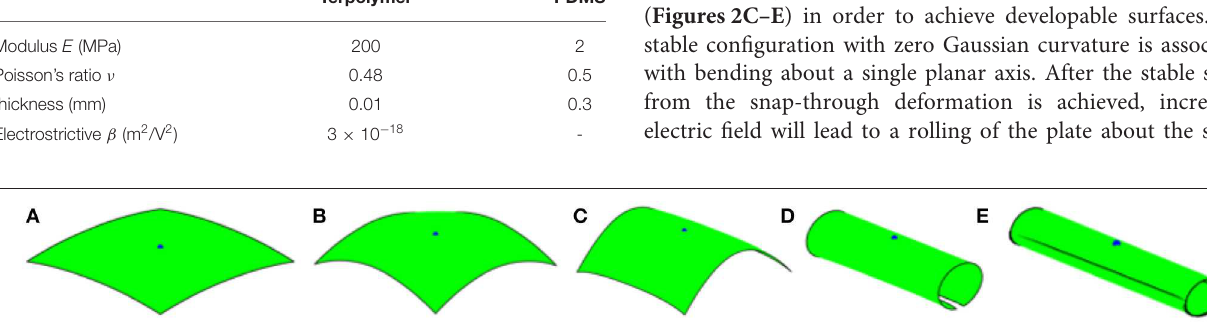
Table 1 . The non-linear electro-mechanical constitutive model is defined for the free expansion/contraction strains H a